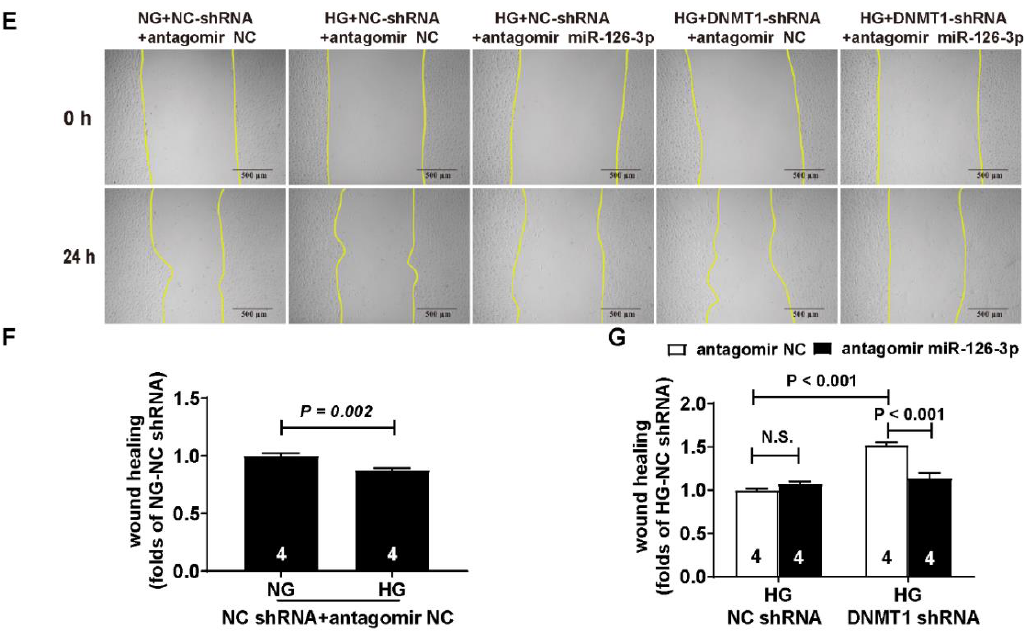
Figure 4. Exogenous H 2 S enhanced the miR-126-3p level and decreased the DNMT1 level in endothelial cells. ( A ) Representative micrographs showing the endothelial cells in the gastrocnemius muscles, 14 days after hindlimb ischemia surgery, stained with mouse antibodies against CD31 and rabbit antibodies against DNMT1; bar = 50 µ m. ( B ) Statistical analysis of the DNMT1 protein expression in the endothelial cells of the gastrocnemius muscles with or without NaHS (30 and 60 µ mol/kg/day) treatment; n = 5~6. ( C ) DNMT1 mRNA level in Matrigel plugs with or without NaHS (30 and 60 µ mol/kg/day) treatment; n = 5~6. ( D ) miR-126-3p level in Matrigel plugs with or without NaHS (30 and 60 µ mol/kg/day) treatment; n = 5~6. ( E ) Representative micrographs of HUVEC scratch wound healing with DNMT1 and miR-126-3p knocked down under high-glucose conditions; bar = 500 µ m. ( F ) Statistical analysis of HUVEC scratch wound healing treated with high glucose; n = 4. ( G ) Statistical analysis of HUVEC scratch wound healing with DNMT1 and miR-126-3p knocked down under high-glucose conditions; n =